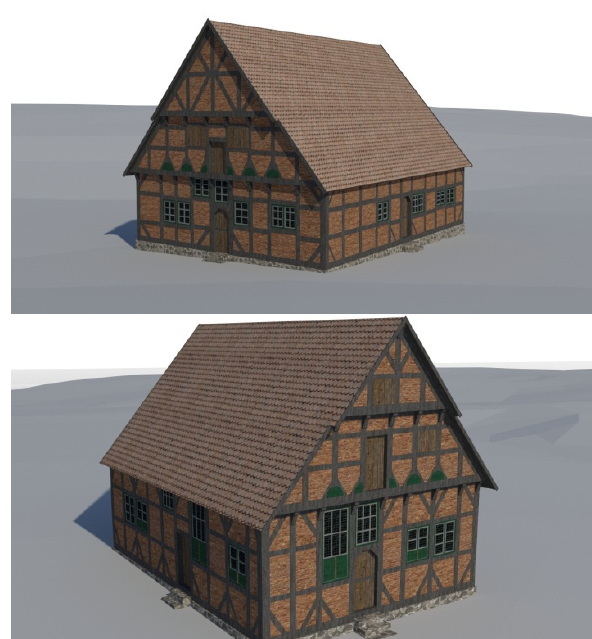
Figure 6. Two different versions of a town house with variations in size, windows and framework